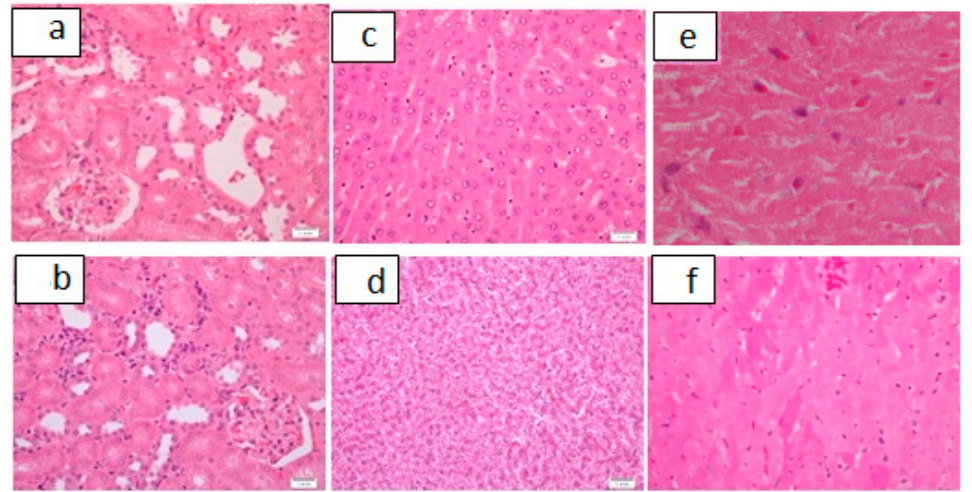
Figure 8. Histological picture of renal hepatic and cardiac tissue in subacute toxicity study at a dose of 3.8 mg/kg . ( a ): Unremarkable renal tissue as seen in sub-acute toxicity (3.8 mg/kg), H&E, ×40. ( b ): Mild renal interstitial inflammation as seen in sub-acute toxicity (3.8 mg/kg), H&E, ×40. ( c ): Unremarkable hepatic tissue as seen in sub-acute toxicity (3.8 mg/kg), H&E, ×40. ( d ): Mild hepatic cytoplasmic vacuolization as seen in sub-acute toxicity (3.8 mg/kg), H&E, ×40. ( e ): Unremarkable cardiac tissue as seen in sub-acute toxicity (3.8 mg/kg), H&E, ×40. ( f ): Mild focal cardiac hyalinization and congestion as seen in sub-acute toxicity (3.8 mg/kg), H&E, ×40.